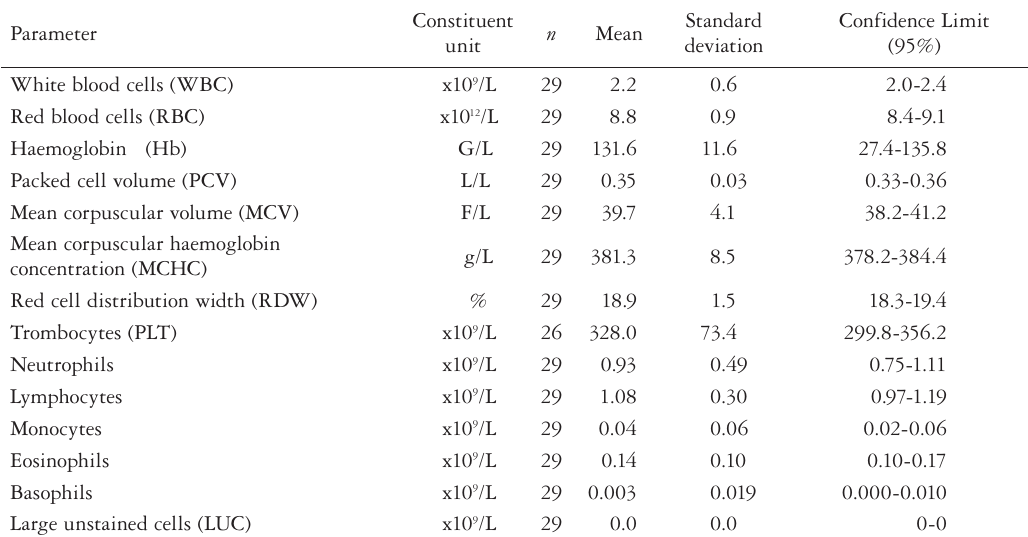
Table 1. Haematological values in free-ranging red deer ( Cervus elaphus atlanticus ) immobilised with xylazine-tiletamin-